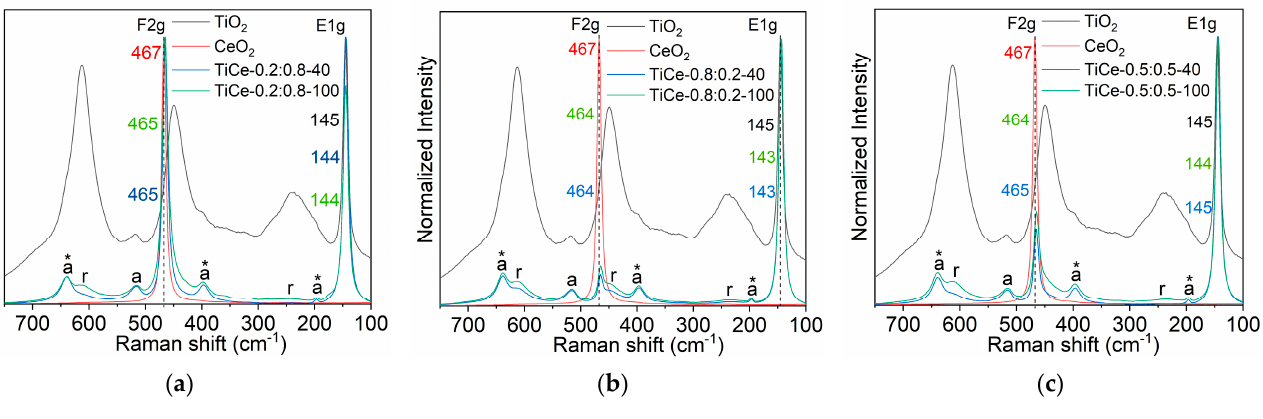
Figure 11. Raman spectrum of: ( a ) TiCe-0.8:0.2-40 and TiCe-0.8:0.2-100; ( b ) TiCe-0.2:0.8-40 and TiCe- 0.2:0.8-100; ( c ) TiCe-0.5:0.5-40 TiCe-0.5:0.5-100; the anatase and rutile bands are marked with “a“ and “r“, respectively. The spectra of mixtures of the same composition are arranged in the same graph.